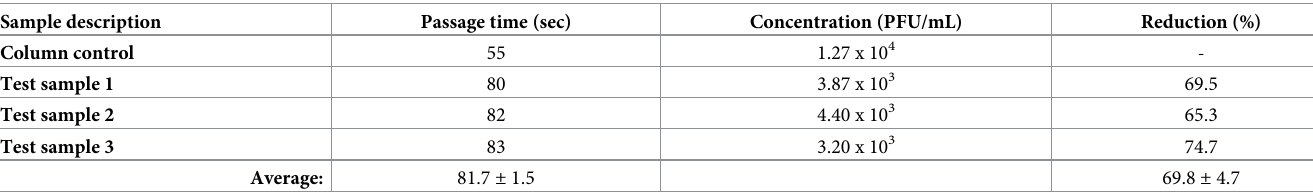
Table 4. NR-54000: Isolate hCov-19/England/204820464/2020 (Lineage B.1.1.7).